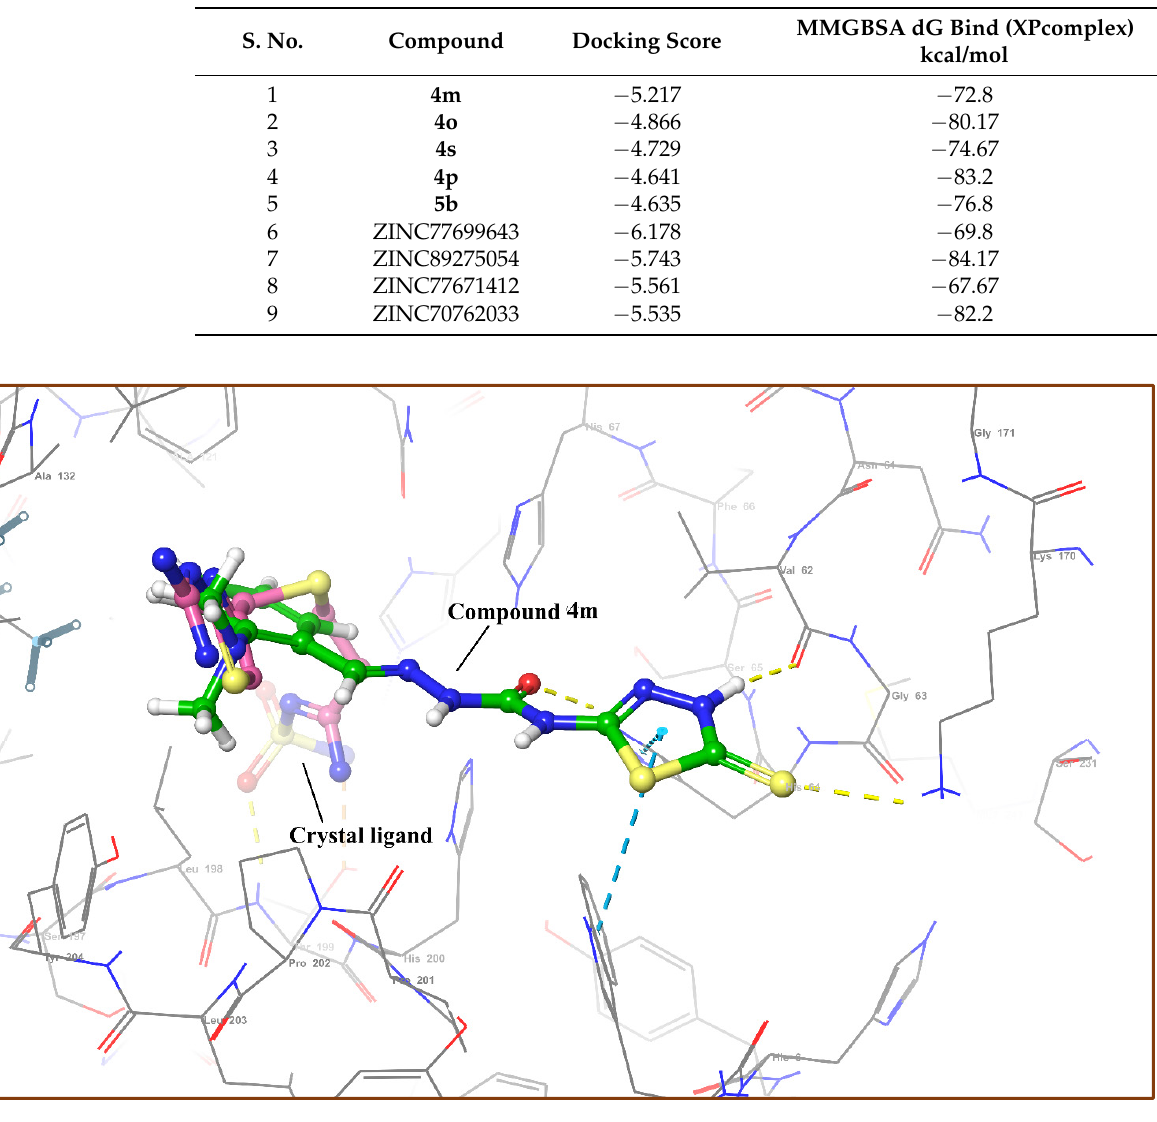
Table 4. Docking scores and MMGBSA-based rescores of compounds taken for QSAR and ZINC database.